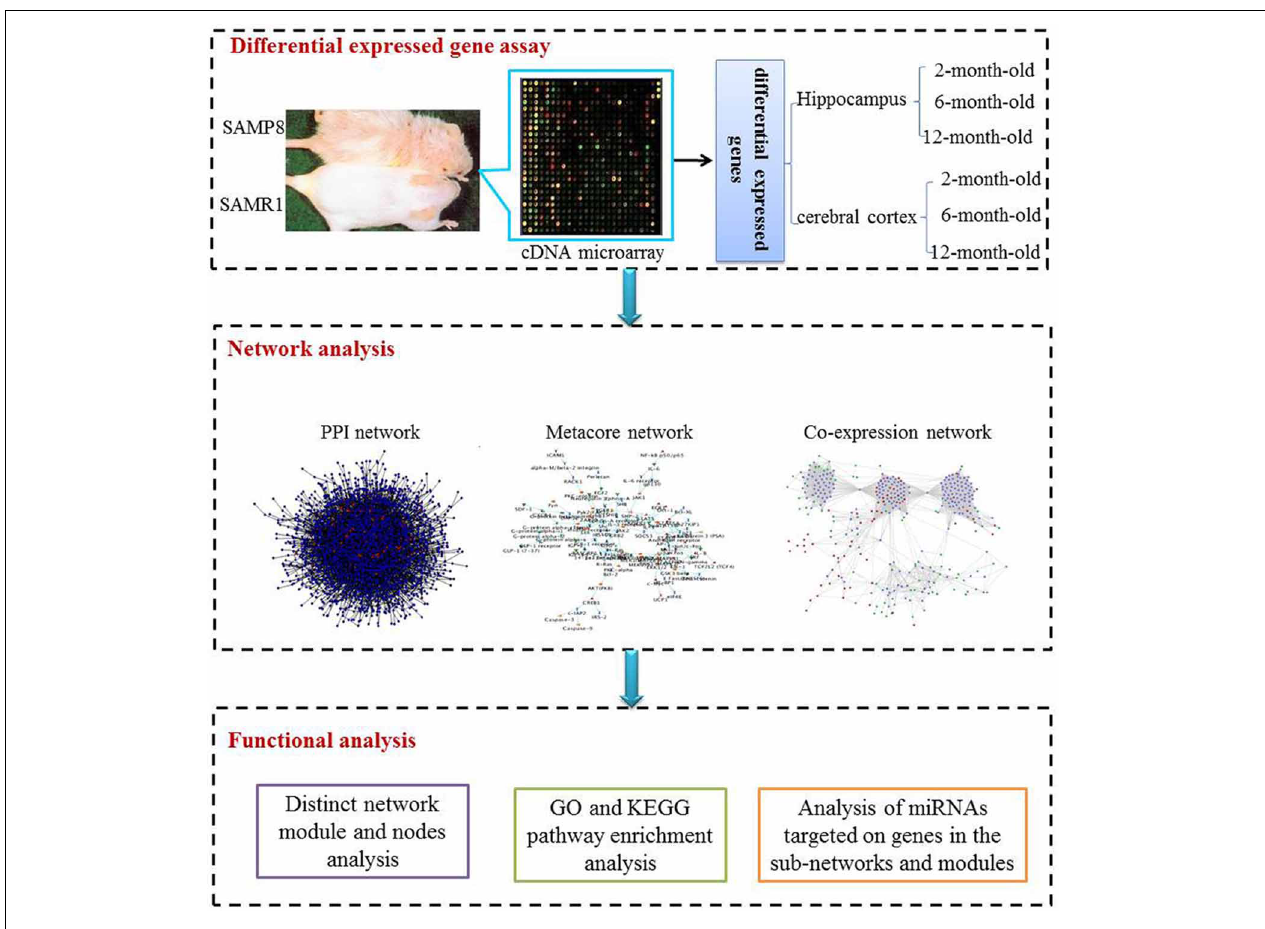
FIGURE 1 | The scheme of analysis procedure. The procedure includes three steps. Firstly differential expressed genes in the hippocampus and cerebral cortex of SAMP8 mice comparing with age-matched SAMR1 mice at the age of 2, 6, and 12 months were identified utilizing the cDNA microarray technique. Then, we inferred three sub-networks based on PPI, MetaCore